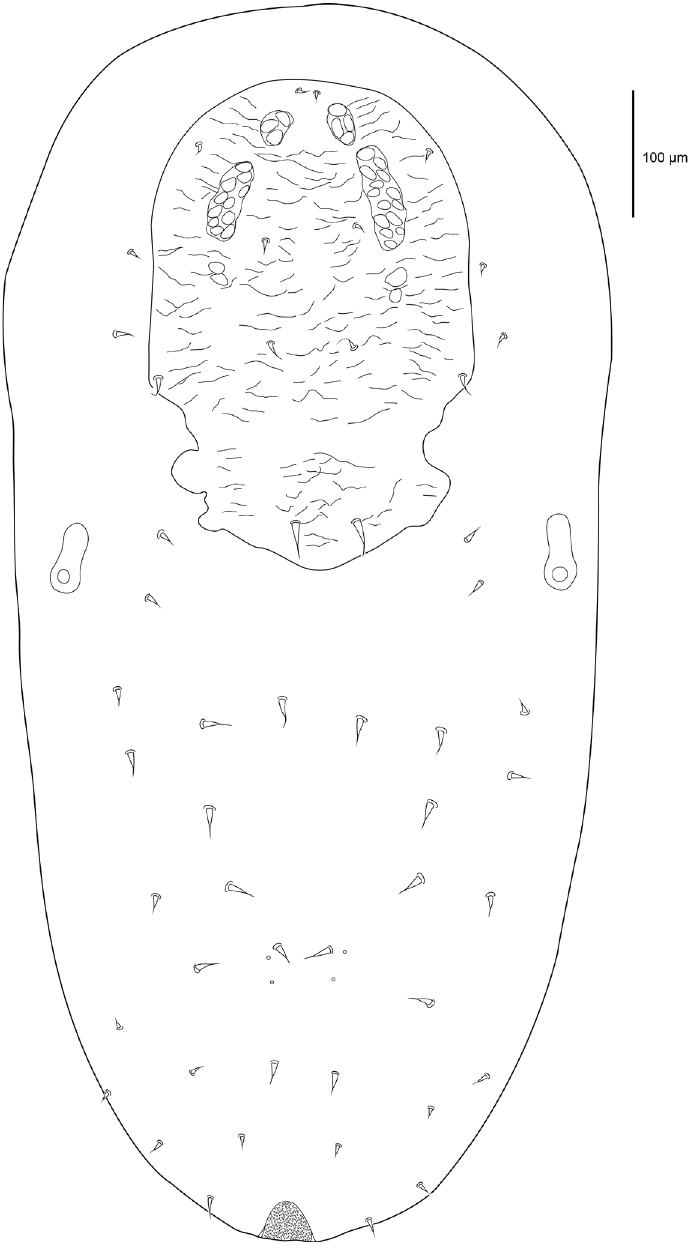
Figure 6. Female Vitznyssus erici sp. n. dorsal eral and posterolateral of podosomal shield, 15–16 pairs of setiform setae 20 (15–22) and two pairs of pore-like structures in dorsal opisthosomal unsclerotised integument. Stigmata with short peritremes 54 (53–55).